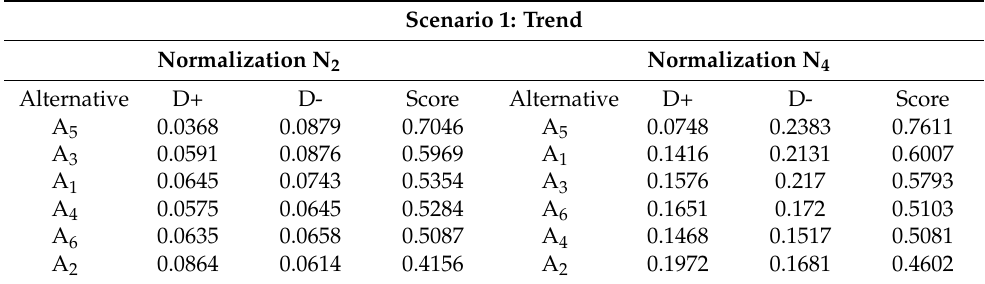
Table 15. Ordering trend scenario.